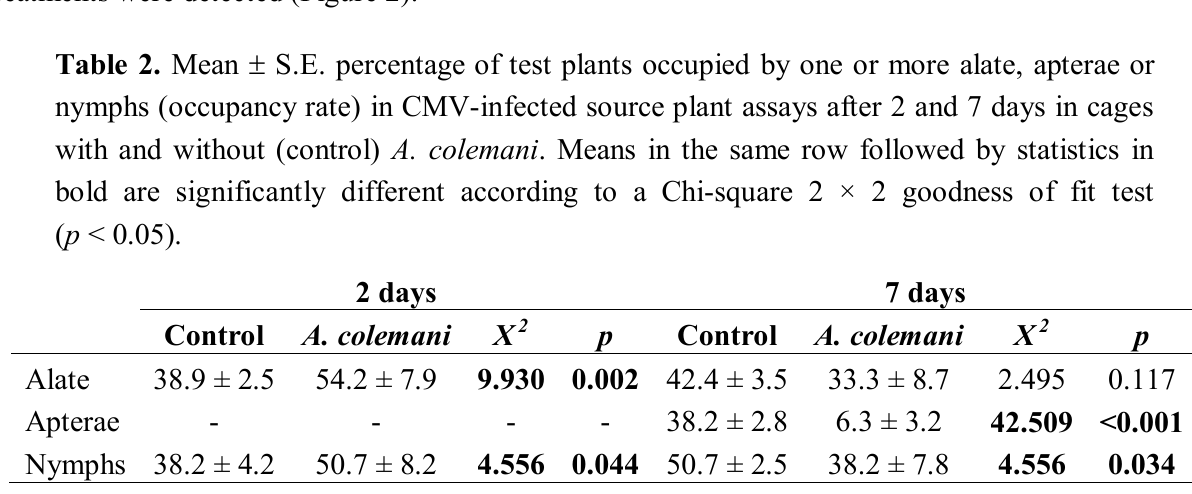
Figure 2. Mean ± S.E. values of virus transmission (%) in the arenas with parasitoids (grey bars) and in those without them (control, white bars). Bars with asterisks indicate significant differences according to a Chi-square 2 × 2 goodness of fit test ( p <